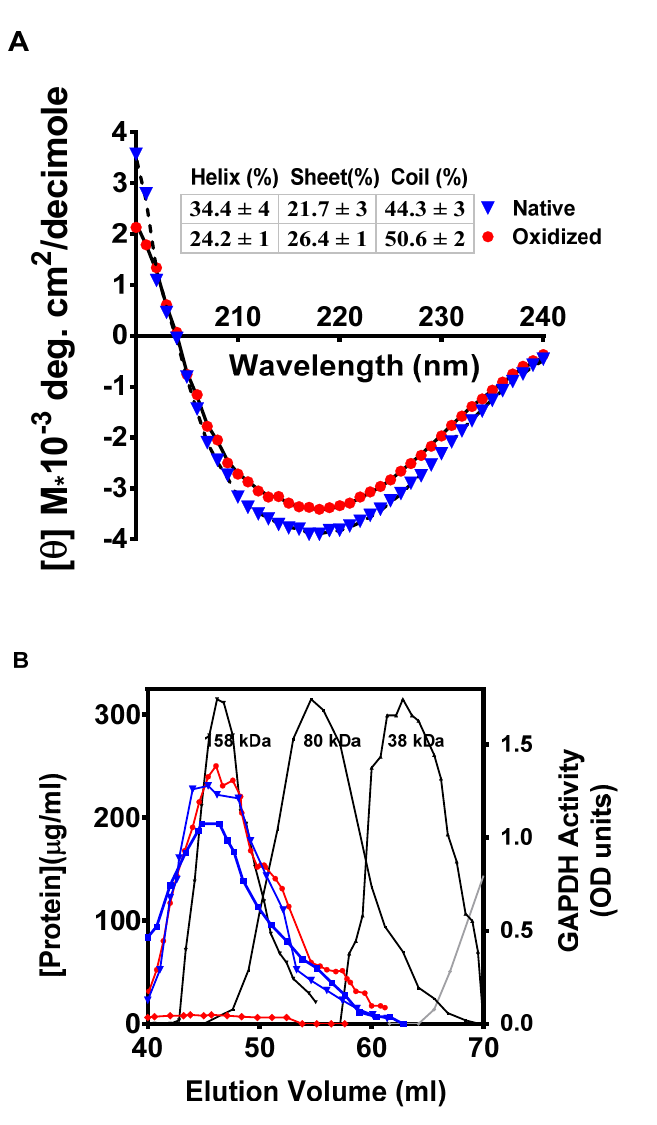
Figure 6. ( A , B ) . H 2 O 2 oxidation of GAPDH is accompanied by significant secondary structural changes in the absence of subunit dissociation. ( A ) CD spectra of native and H 2 O 2 − oxidized p − GAPDH at 4 ◦ C. Secondary structure parameters from the analysis are tabulated in the insert and show a significant loss of α − helix. The spectra were unchanged between measurement within the shortest timeframe for oxidation and spectra collection and after 1 − 2 h incubation at 4 ◦ C, showing that the subunit rearrangement was stabilized at low temperature. ( B ) Combined overlaid gel filtration chromatograms of native and oxidized p − GAPDH at 4 ◦ C. Calibrator MW standard protein elution profiles are shown in black. Native p − GAPDH protein content, native enzyme activity, H 2 O 2 − oxidized p − GAPDH protein content, and p − GAPDH residual enzyme activity all co − elute from the column at the expected MW of p − GAPDH homotetramer at ~148 kDa.